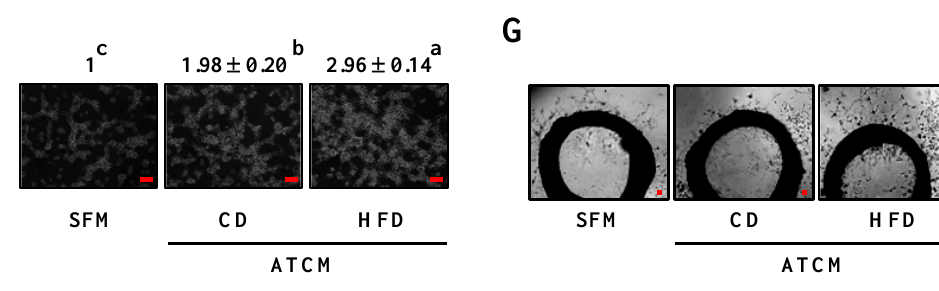
Figure 6. Adipose tissue-conditioned media (ATCM) from high-fat diet-fed mice stimulate the proliferation and migration of prostate cancer cells and angiogenesis. ( A ) TRAMP-C2 cells were treated with 0 or 50% ATCM for 24 h. Cell viability was determined by MTT assay. Each bar represents the mean ± SEM ( n = 3); ( B ) Total cell lysates were prepared and analyzed via Western blot analysis with the indicated antibodies. The relative abundance of each band to its own β-actin was quantified and the control levels were set at 100%. The adjusted mean ± SEM ( n = 3) is shown above each blot; ( C – E ) The migration of TRAMP-C2 cells through a type IV collagen-coated transwell filter was assessed. Fifty percent ATCM ( C ) or 100 μg/L recombinant proteins ( D ) were added to the lower chamber of the transwell as a chemoattractant; ( E ) CXCL13 (100 μg/L) was added to the lower chamber and TRAMP-C2 cells were pretreated with CXCR5 antibody (1 mg/L). Each bar represents the mean ± SEM ( n = 3). ( F ) HUVEC tube formation assay. Cumulative tube length was quantified and shown above each photograph. The control levels were set at 1. Each value represents the mean ± SEM ( n = 3); ( G ) Aorta ring assay. The photographs, which